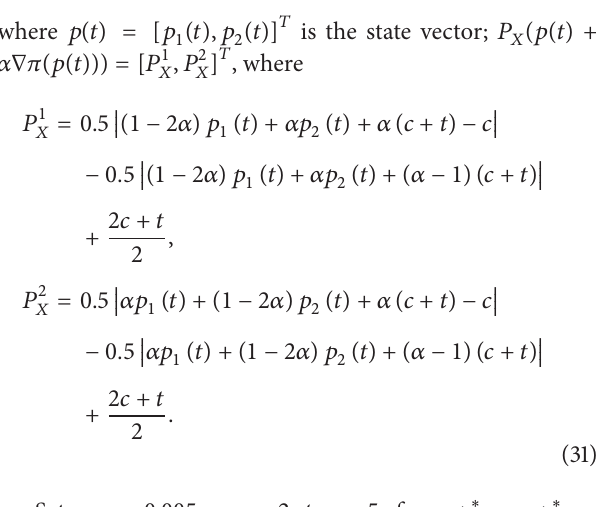
the Nash equilibrium point is 𝑝 ∗ 1 = 𝑝 ∗ 2 = 𝑐+𝑡 [27]. Obviously, 2 𝑋 𝑋 = {𝑝 : 𝑐 ≤ 𝑝 ≤ 𝑐 + 𝑡} , 𝑖 = the strategy set 𝑋 = Π 𝑖 , 𝑖 𝑖 𝑖 𝑖=1 1, 2 , is nonempty, closed, and convex, and profit functions (𝑝 , 𝑝 ), 𝑖 = 1, 2 , satisfy assumption (2) . By Section 4, we 𝜋 𝑖 1 2